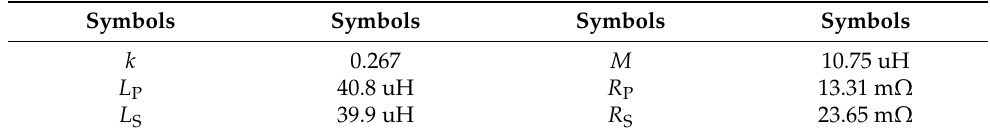
Table 2. Measured LCT parameters. Symbols Symbols Symbols